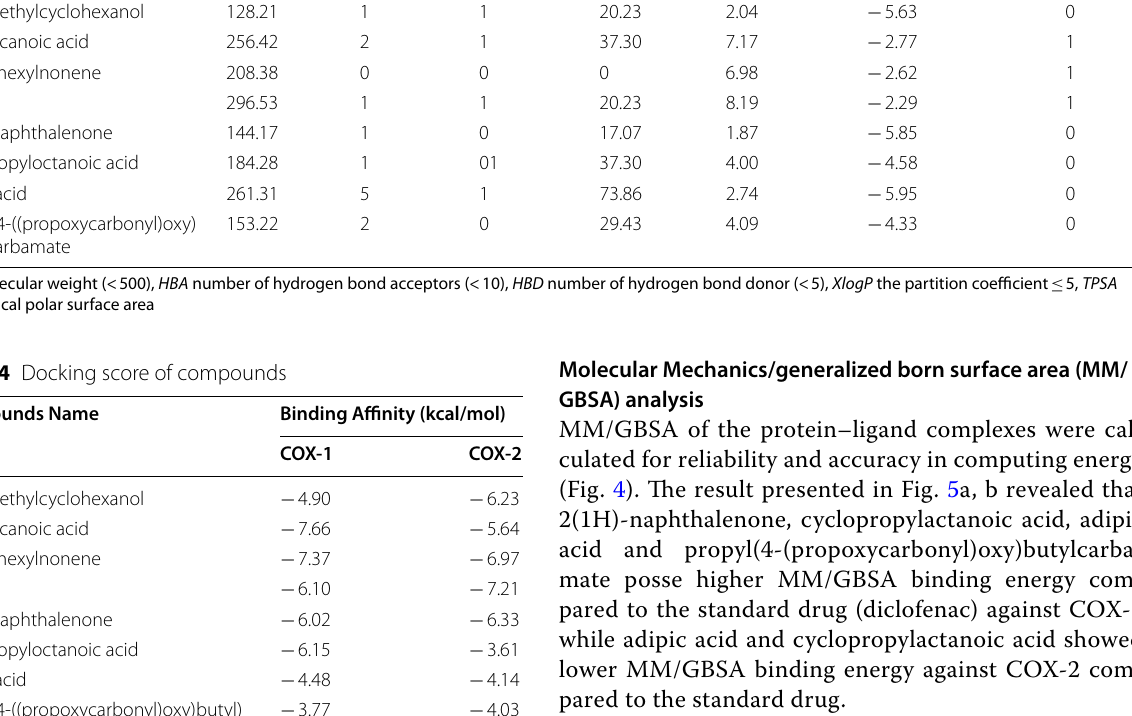
Table 3 In silico drug likeness prediction of the compounds